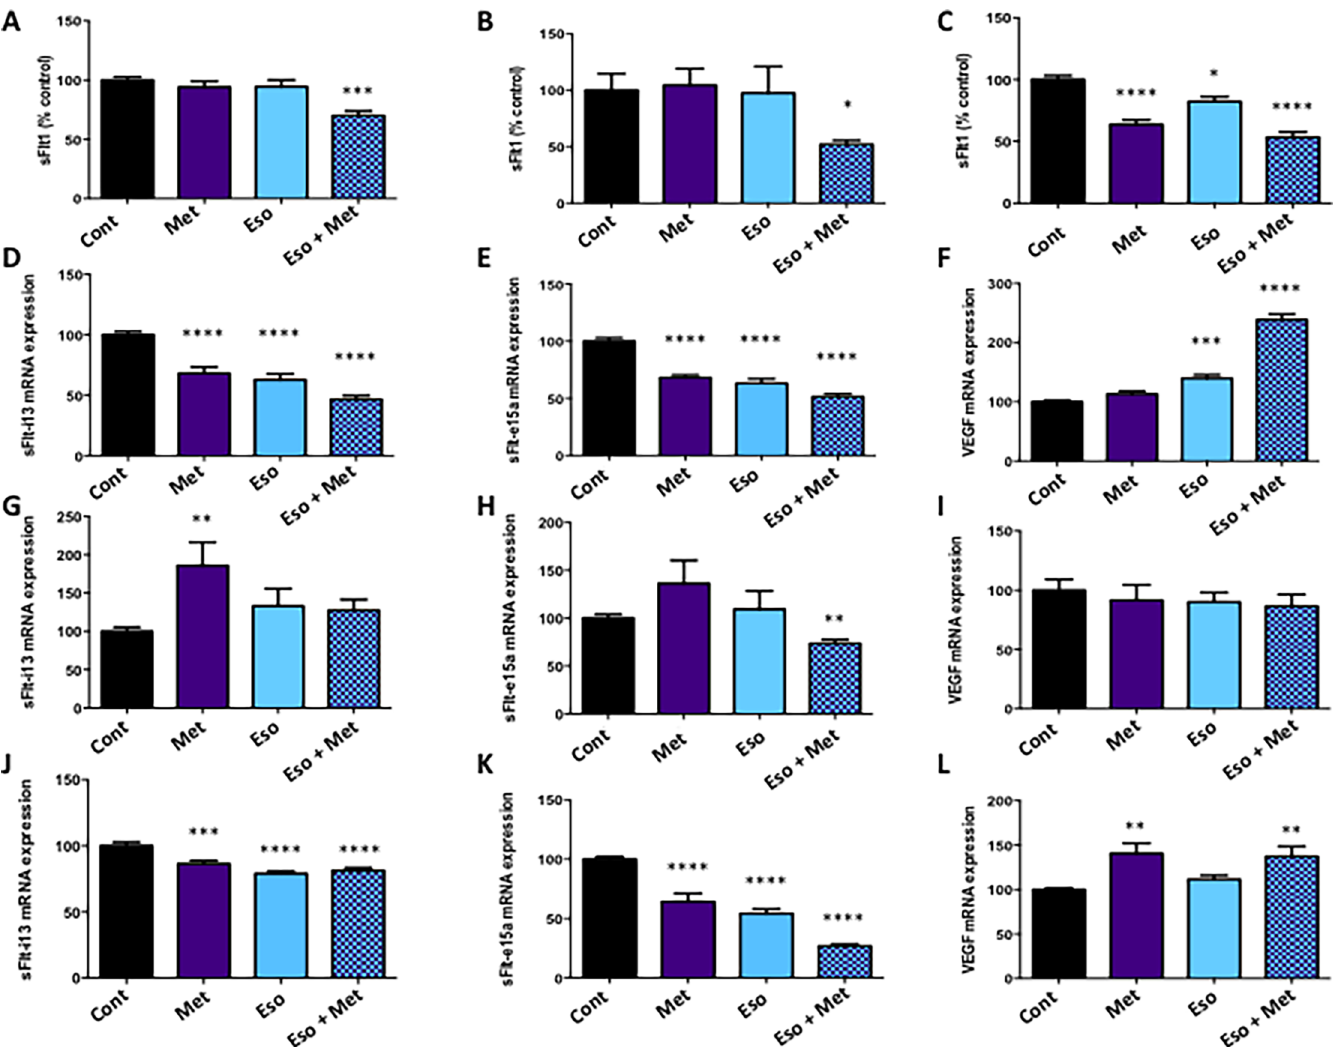
Fig 1. Combining metformin and esomeprazole additively decreases sFlt-1 secretion and expression, and increases VEGF expression in placental and endothelial cells. Isolated primary cytotrophoblast were treated with either metformin alone (Met), esomeprazole alone (Eso) or Met + Eso in combination and the effect on sFlt-1 secretion assessed (A). Neither Met or Eso alone reduced sFlt-1 secretion, however a significant reduction was observed when the two were added in combination (A). Similarly, neither Met nor Eso alone altered sFlt-1 secretion from placental explants, but sFlt-1 secretion was significantly reduced with combination Met and Eso treatment (B). In primary HUVECs, secretion of sFlt-1 was significantly reduced with all treatments compared to control (C). In primary cytotrophoblast both Met and Eso alone significantly reduced sFlt-1 i13 (D) and sFlt-1 e15a mRNA expression (E). A significant increase was observed in VEGF mRNA expression with Eso and Met treatment (F). Met treatment of placental explants caused a significant increase in the expression of sFlt-1-i13 (G) whilst combination Met + Eso caused a significant reduction in the expression of sFlt-1-e15a (H). No change was observed in placental VEGF mRNA expression with any treatment (I). In primary HUVECs, significant reductions in sFlt-1 i13 (J) and sFlt-1 e15a (K) compared to control were observed when Met or Eso were added alone. Combination Met + Eso also significantly reduced expression of both variants compared to control (J-K). VEGF mRNA was significantly increased with either Met alone, and with combination of Met + Eso treatment (L). The following treatment doses were used: Cytotrophoblasts : Met; 125 μM, Eso; 25 μM or same doses in combination. Placental explant tissue : Met; 500 μM, Eso; 25 μM or same doses in combination. HUVECs :Met; 1000 μM, Eso; 25 μM or same doses in combination. All treatments were carried out over 48 h. Data are mean fold change from control ± SEM ( (cid:3) p < 0.05, (cid:3)(cid:3) p < 0.01, (cid:3)(cid:3)(cid:3) p < 0.001, (cid:3)(cid:3)(cid:3)(cid:3) p < 0.0001 compared to control). (n (cid:21)